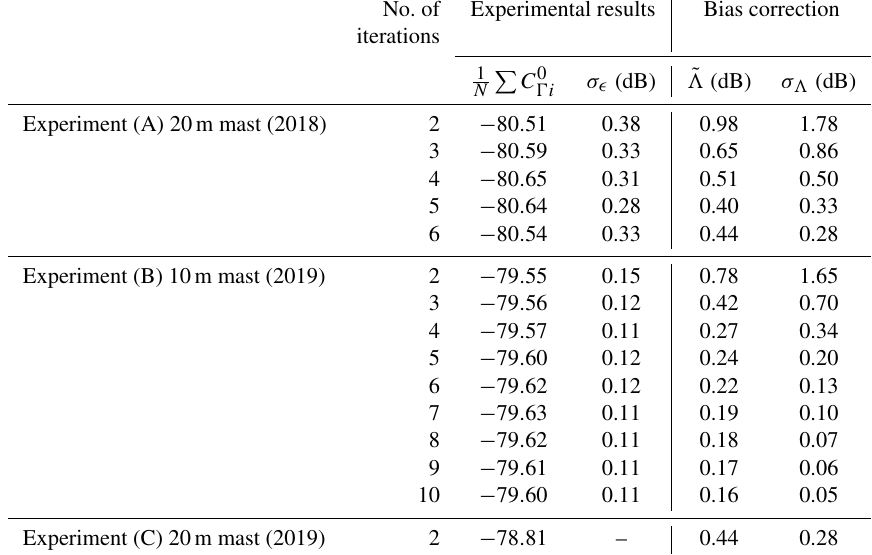
Table 1. Bias correction ˜ (cid:51) and its uncertainty σ (cid:51) calculated using a different number of iterations for the experiments of the 2018 and 2019 calibration campaigns (e.g., three iterations means we used iterations 1, 2 and 3 of the experiment). We include the average and spread σ (cid:15) between the retrieved C 0 for each case. This variability σ (cid:15) is introduced in the bias estimation procedure to determine the bias correction ˜ (cid:51) (cid:48)i and its uncertainty σ (cid:51)